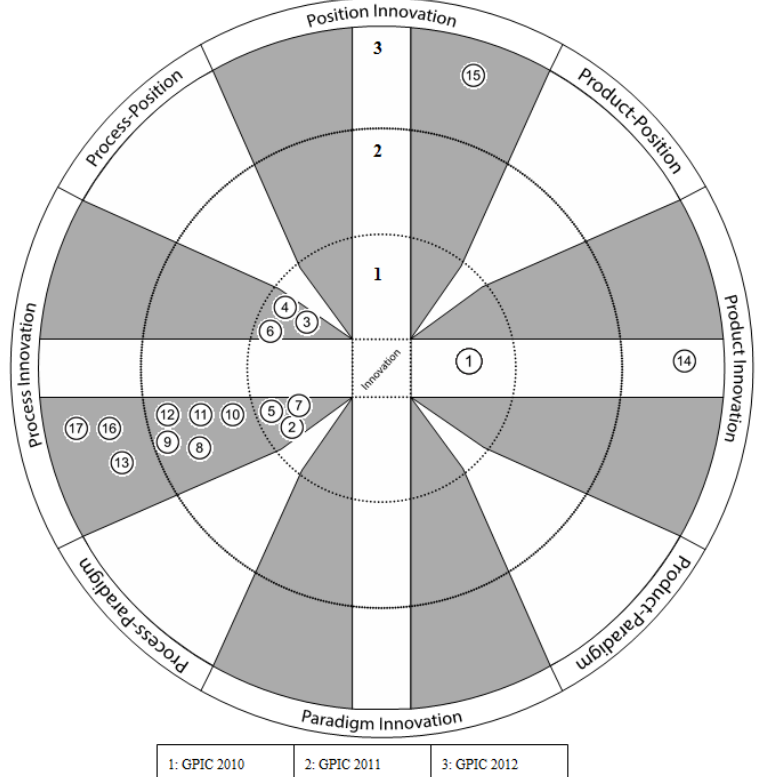
Fig. 3. Mapping Innovation of GPIC from 2010 to 2012 Using 10Ps Benchmarking Innovation Mapping